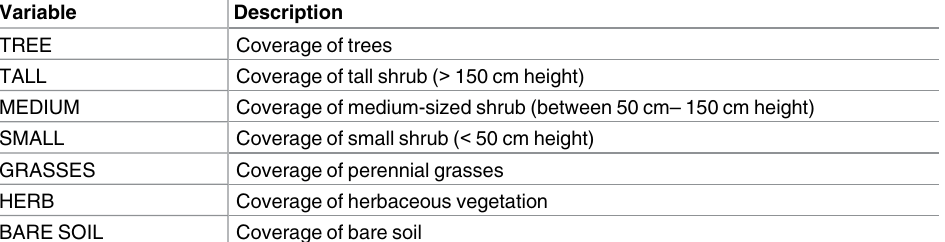
Table 1. Vegetation and soil categories assessedin the microhabitat analysis. Seven coveragecatego- ries were used for each variable:1 = 0–1%; 2 = 2–10%; 3 = 11–33%;4 = 34–50%;5 = 51–66%;6 = 67–90%; 7 = 91–100%.